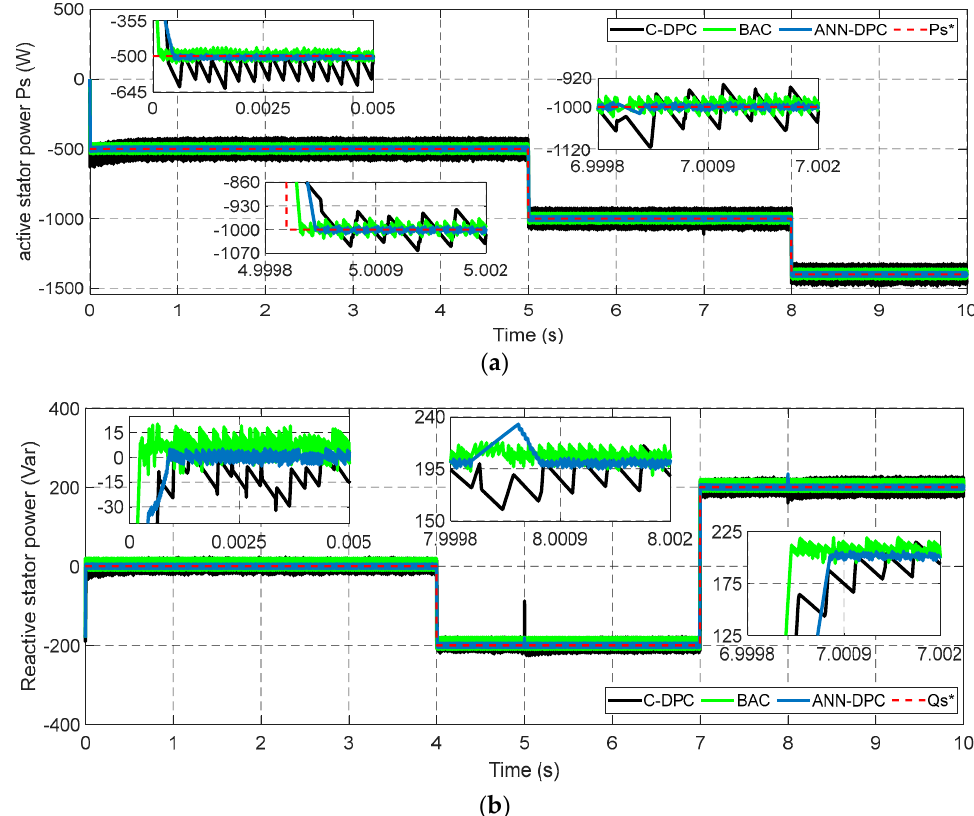
Figure 22. Powers after variation of all parameters of the DFIG with − 50%, ( a ) Ps , ( b ) Qs .